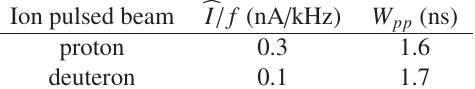
Table 3. List of average-current / frequency ratio ( peak-to-peak width ( W pp ) of the protons and deuterons pulsed beams measured during the tests.